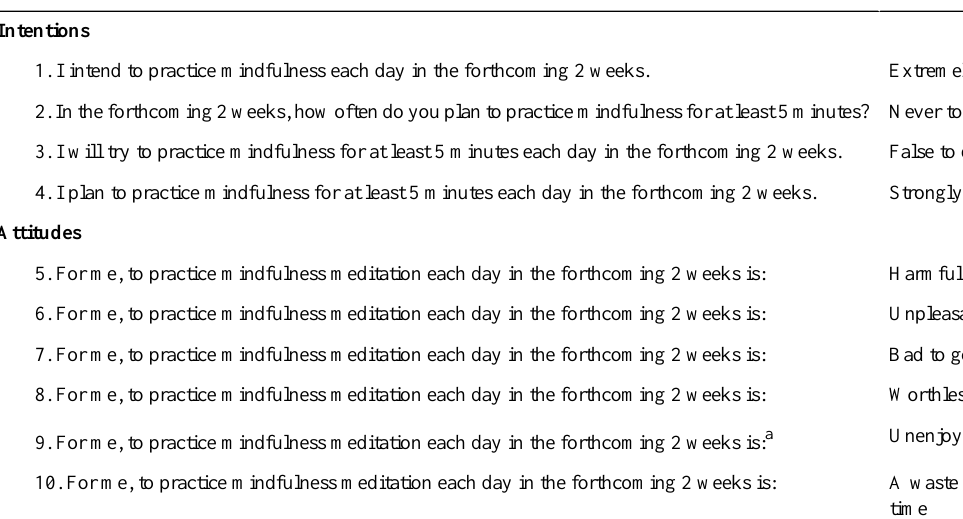
Response option